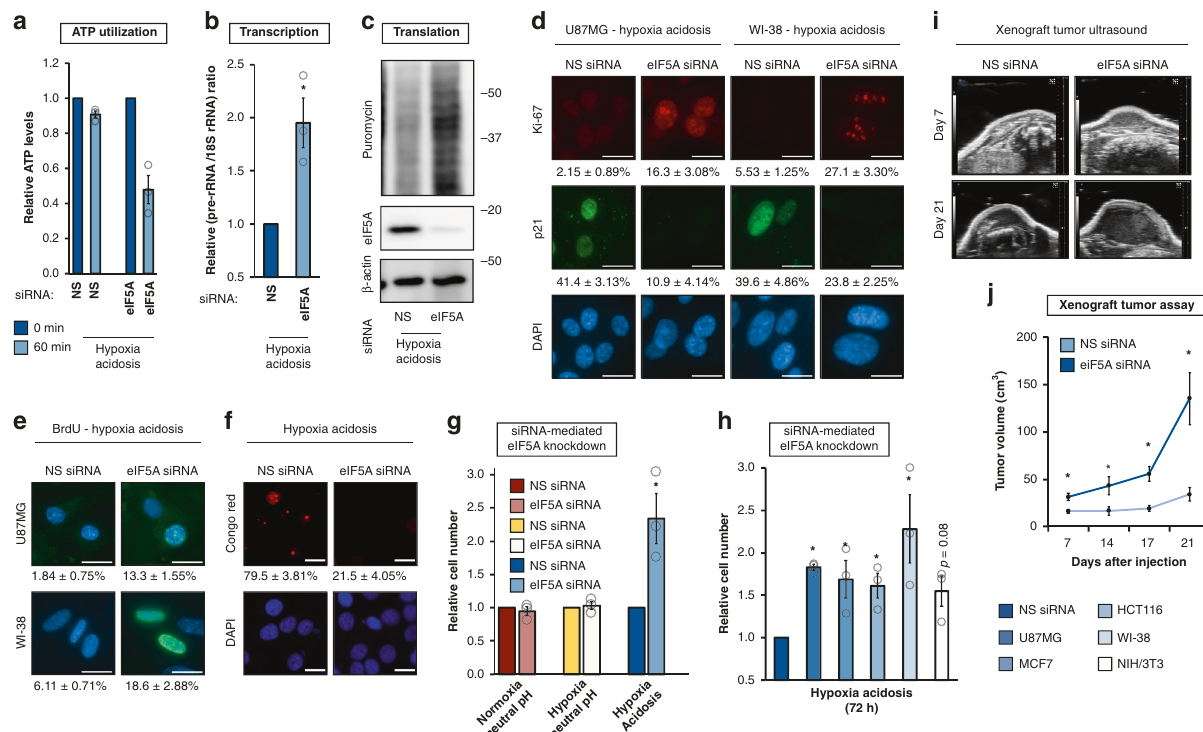
Fig. 2 eIF5A enables metabolic depression during anaerobic acidosis. a Relative ATP utilization, b transcriptional intensity, and c translational intensity in U87MG replete or depleted of eIF5A under hypoxia acidosis conditions. a , b NS nonsilencing. Data represent mean ± SEM ( n = 3). An asterisk indicates p = 0.024, 0.028 ( a , b ) compared to NS siRNA, two-sided student ’ s t test. d Ki-67 and p21 immunocytochemistry, e DNA replication (BrdU staining), and f Congo red staining for A bodies in U87MG replete or depleted of eIF5A under hypoxia acidosis conditions (72 h) ( n = 5). Quantitation in ( d ) and ( e ) represents mean ± SEM ( n = 7, 5). Scale bars: 20 μ m. g Effect of eIF5A knockdown on steady-state cell numbers in U87MG subjected to indicated treatments. NS nonsilencing. Data represent mean ± SEM ( n = 3). An asterisk indicates p = 0.035 compared to NS siRNA, two-sided student ’ s t test. h Effect of eIF5A knockdown on steady-state cell numbers in human and mouse cell lines under hypoxia acidosis conditions. NS nonsilencing. Data represent mean ± SEM ( n = 3). An asterisk indicates p = 0.001, 0.001, 0.047, and 0.025 (U87MG, MCF7, HCT116, and WI-38) compared to the corresponding NS siRNA, two-sided student ’ s t test. i Representative ultrasound images and j tumor volume measurements of mouse xenograft tumor- formation assays using MCF7 replete or depleted of eIF5A and pretreated with hypoxia acidosis for 72 h. Data represent mean ± SEM ( n = 6). An asterisk indicates p = 0.021, 0.031, 0.004, and 0.014 (days 7, 14, 17, and 21) compared to NS siRNA, two-sided student ’ s t conditions and did not lead to an increase in cell number in HA addition, eIF5A silencing led to an increase in cellular prolifera- as we observed with speci fi c eIF5A silencing (Supplementary tion as demonstrated by Ki-67/p21 staining (Fig. 2d), BrdU Fig. 3i). These fi ndings precluded its use as a surrogate for eIF5A- labeling (Fig. 2e), and fl ow cytometry analysis (Supplementary speci fi c silencing. Overall, these data suggest that eIF5A sup- Fig. 3d). We also observed a decreased number of A bodies presses metabolism in cells exposed to anaerobic acidosis. (Fig. 2f) and a reversal of cellular patterning (Supplementary Fig. 3e). Overall, these effects of eIF5A knockdown resulted in